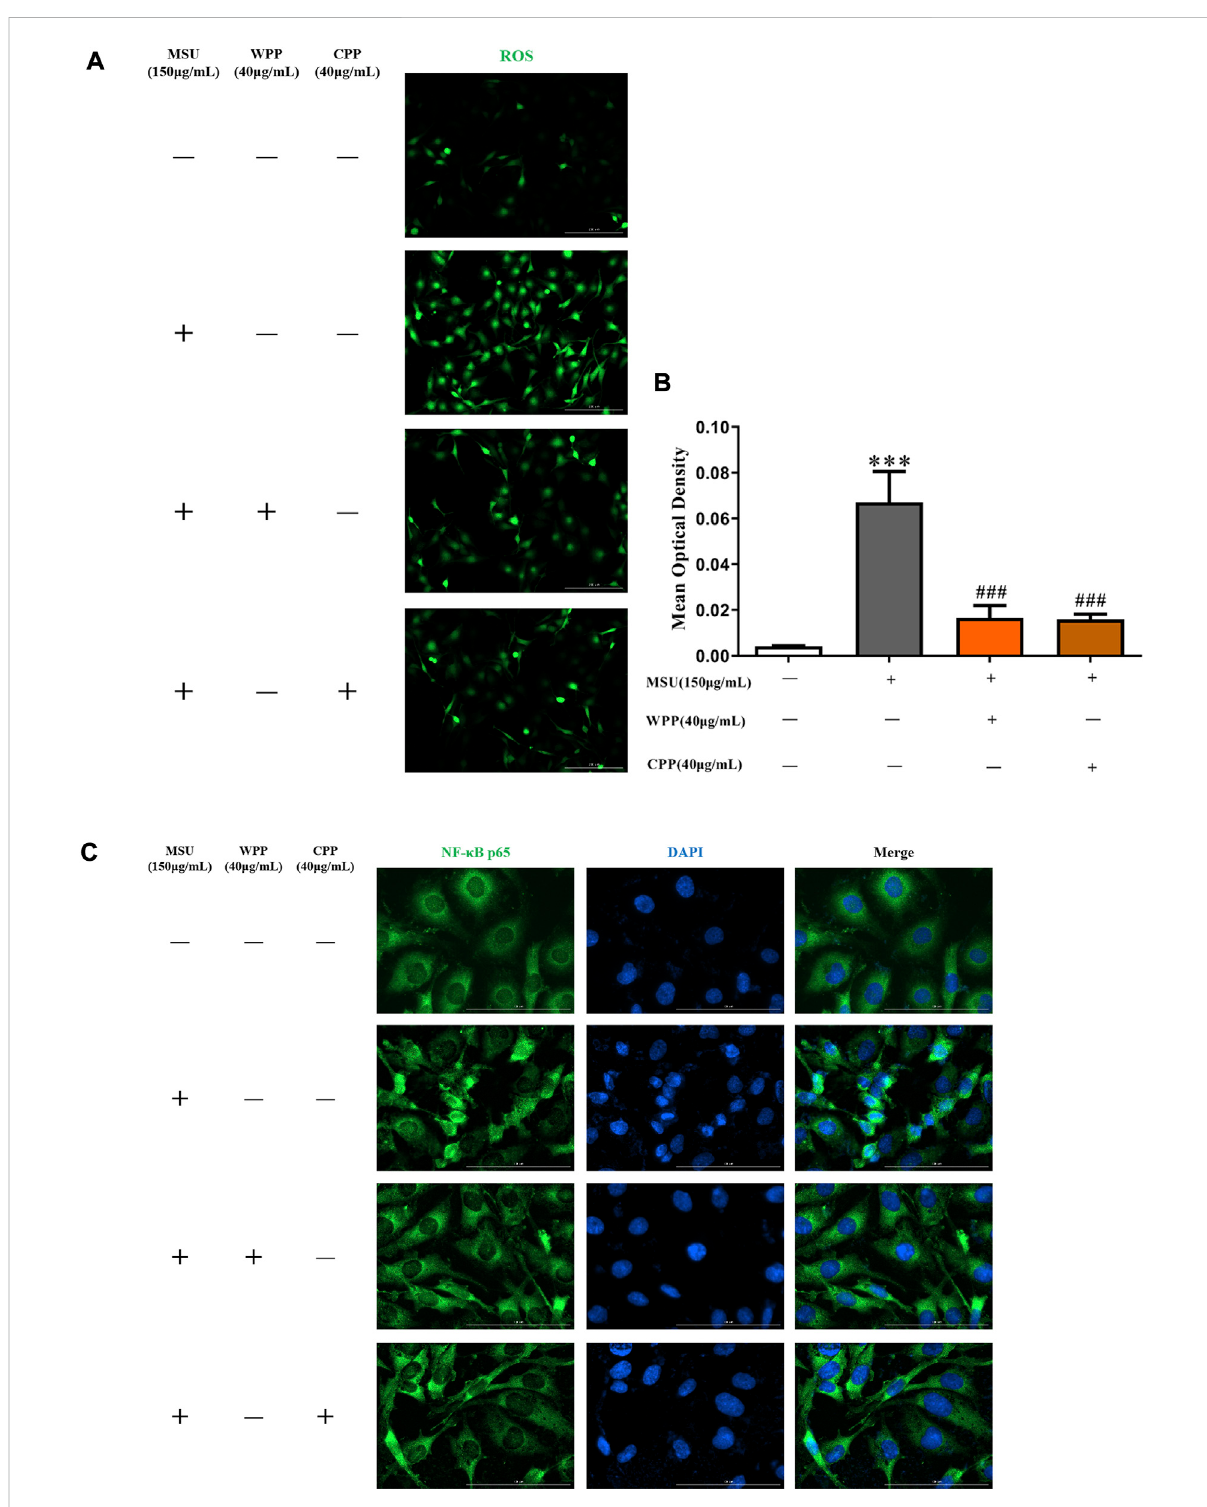
FIGURE 5 The generation of ROS was compared by IF (A) , scale bar = 200 μ m, and the fl uorescence intensity was quantitatively analyzed (B) , *** p < 0.001 vs. the control group; ### p < 0.001 vs. the model group; n = 3. Effect of WPP and CPP on NF- κ B p65 nuclear translocation by IF (C)